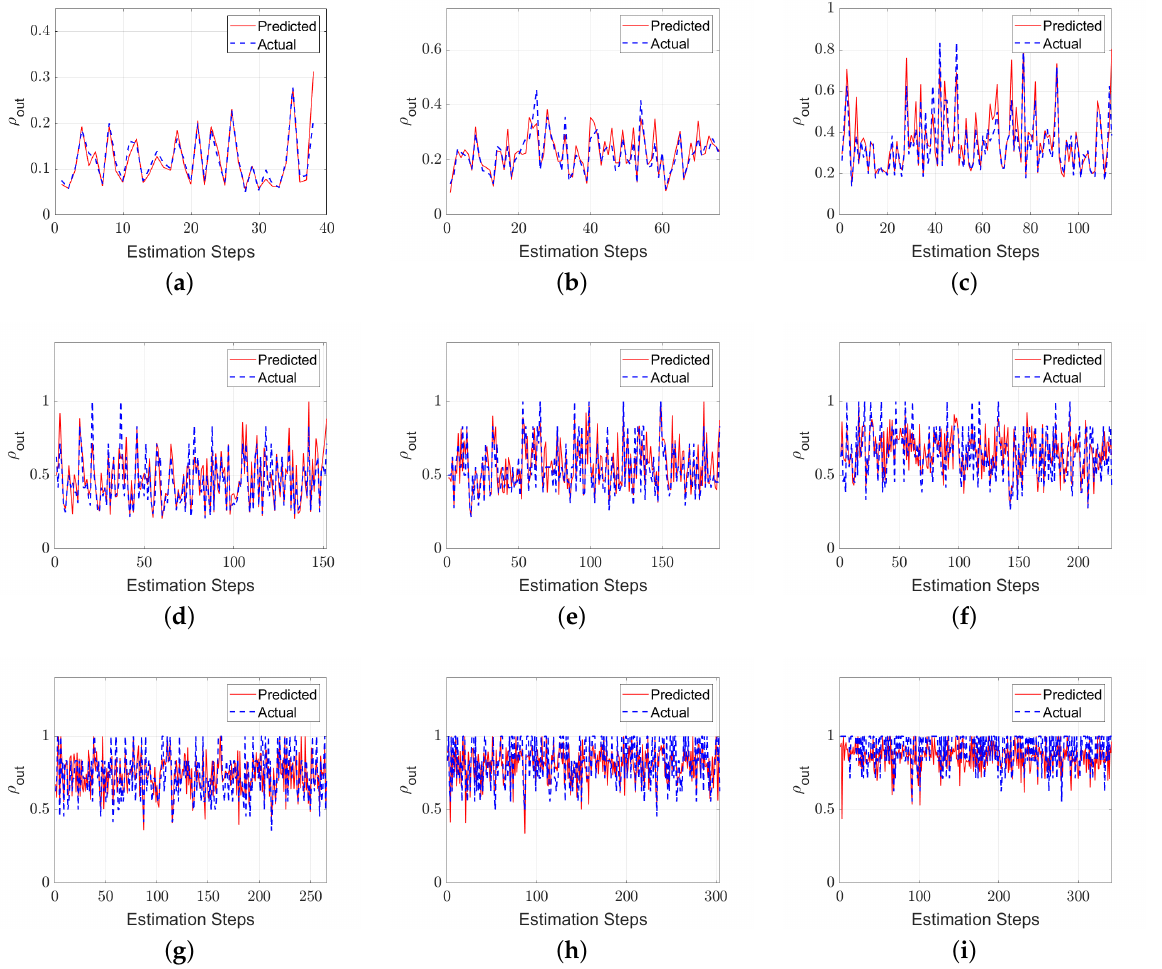
Figure 4. Actual and estimated values of ρ out for different level of market penetration (LMP)